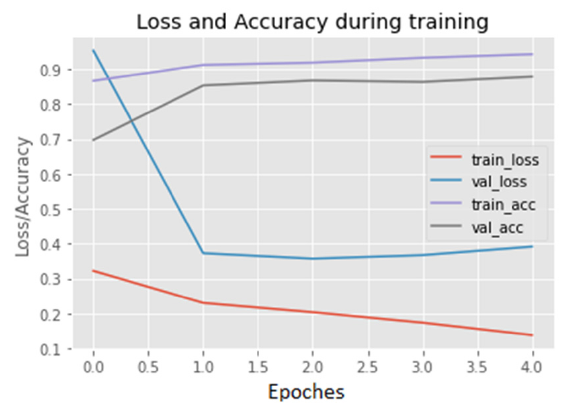
Figure 12. Loss and accuracy during training.